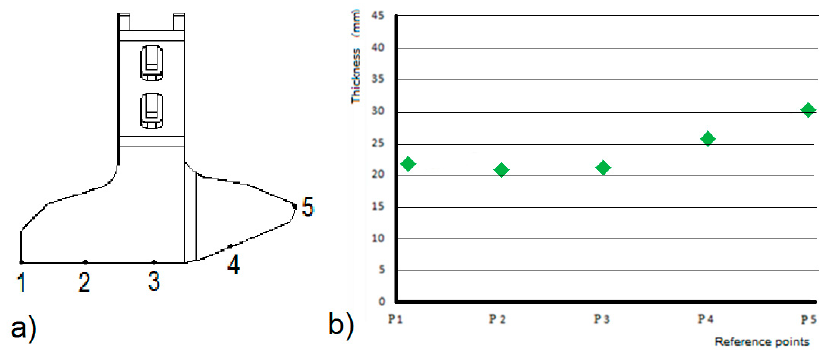
Figure 2. Reference points ( a ) and mean thickness of the worn material ( b ).